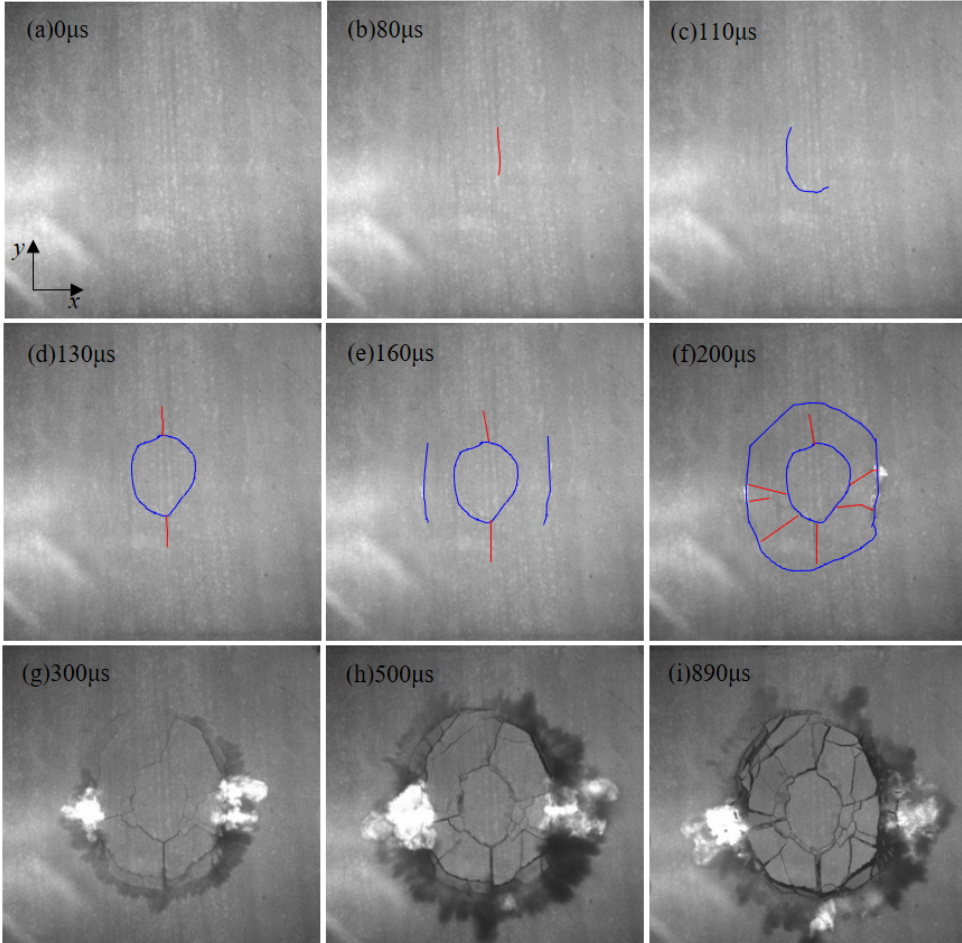
Figure 6. The crack network at different times during crater blasting under an SSR of 0.2. ( a – i ) The crack network after 0, 80, 110, 130, 160, 200, 300, 500, and 890 μs of explosion, respectively. The morphological characteristics of the crack network under SSR of 0.2 were basically similar to those under an SSR of 0.15, both of which were elliptical with a long axis that was parallel to the static stress, as shown in Figures 5 and 6. However, when the SSR was 0.2, the radial cracks in the centre of the blast hole that were perpendicular to the static stress were completely restrained and did not appear. Moreover, when compared with the SSR of 0.15, the ellipse phenomenon of the crack network under the SSR of 0.2 was more obvious. 3.5. Evolution of the Crack Network under an SSR of 0.3 Figure 7 shows the initiation and propagation process of the crack network during crater blasting under an SSR of 0.3. Under the coupling of dynamic and static loads, an initial radial crack that was parallel to the static stress was observed first at the center of the blast hole at 80 μs (see Figure 7b). Similar to the experimental results that were